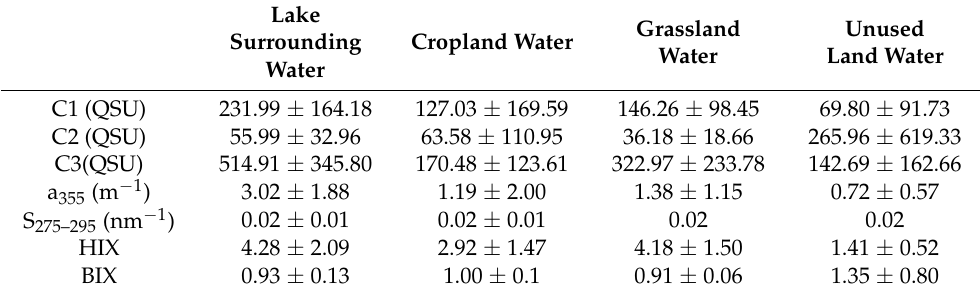
Table 1. Indices of fluorescence and UV detection in water regimes of different land-use